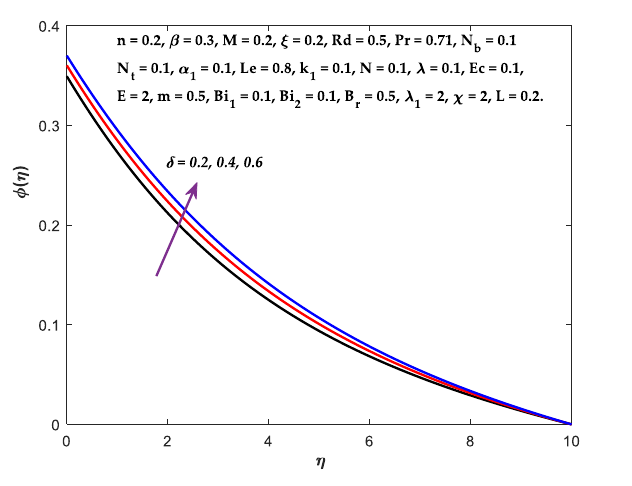
Figure 17. Diagram of δ v/s φ(η) .